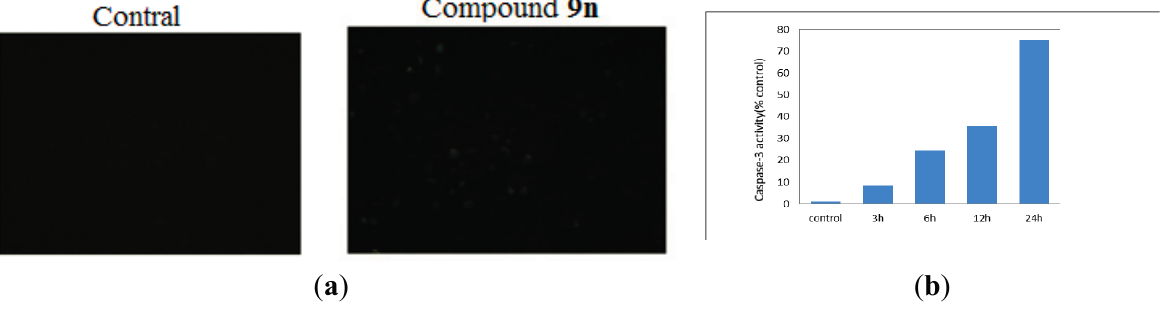
Figure 9. ( a ) Activation of Caspase-3 induced by compound 9n , examined by FITC-DEVD-FMK under a fluorescent microscope; ( b ) Measurement of caspase-3 activity. Dose-dependent induction of caspase-3 in human HeLa cell